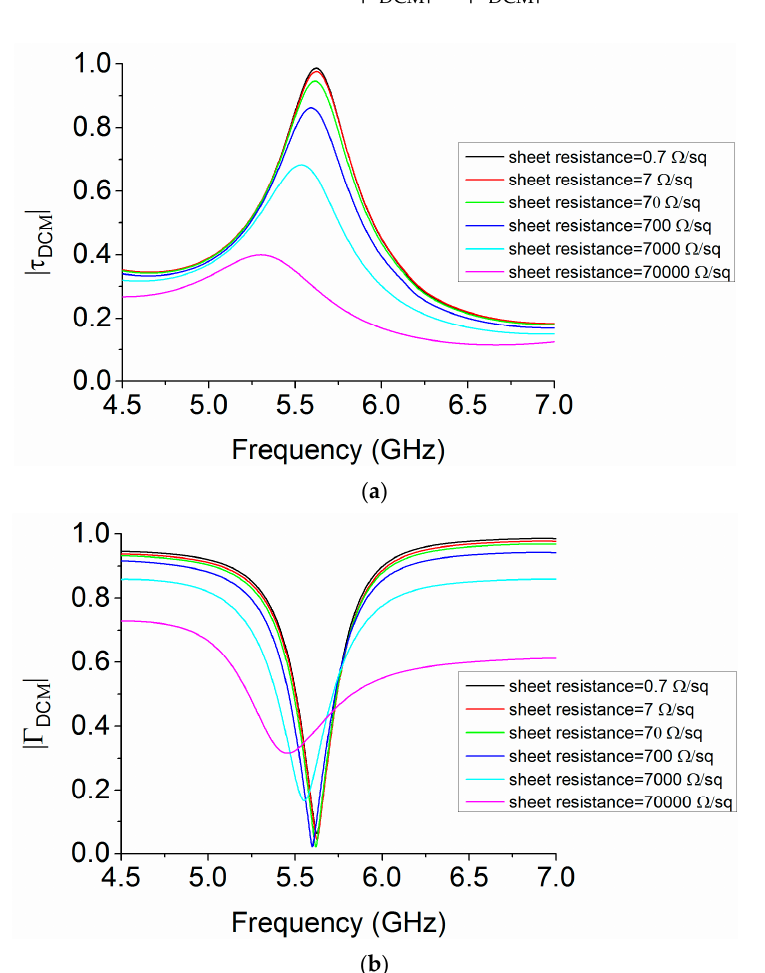
Figure 7. Computed reflection and transmission magnitude using different values of sheet resistance ( a ) | τ DCM | ( b ) | Γ DCM | .